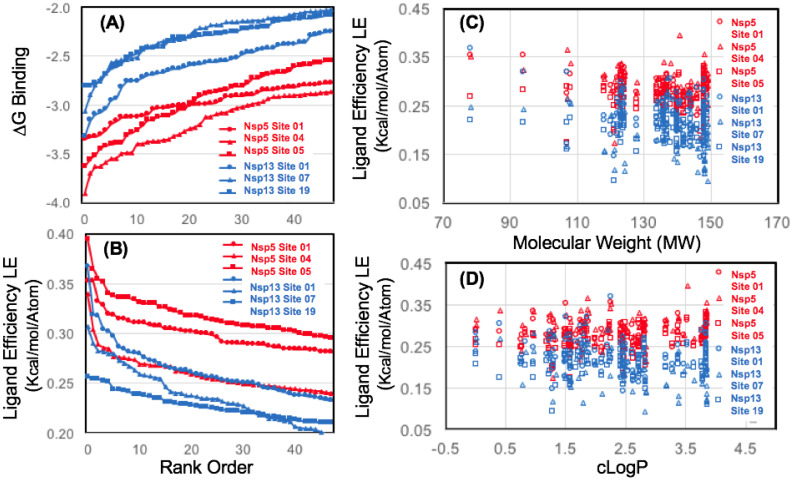
Ligand efficiency for several favorable binding sites on Nsp5 Mpro and Nsp13 helicase from computational fragment screening.Data is shown for ΔGbind (A) and ligand efficiency (B) comparing numerous sites using the FRAG100 library as a benchmark. Ligand efficiency data is also shown as a function of fragment molecular weight (C) and calculated LogP (D).